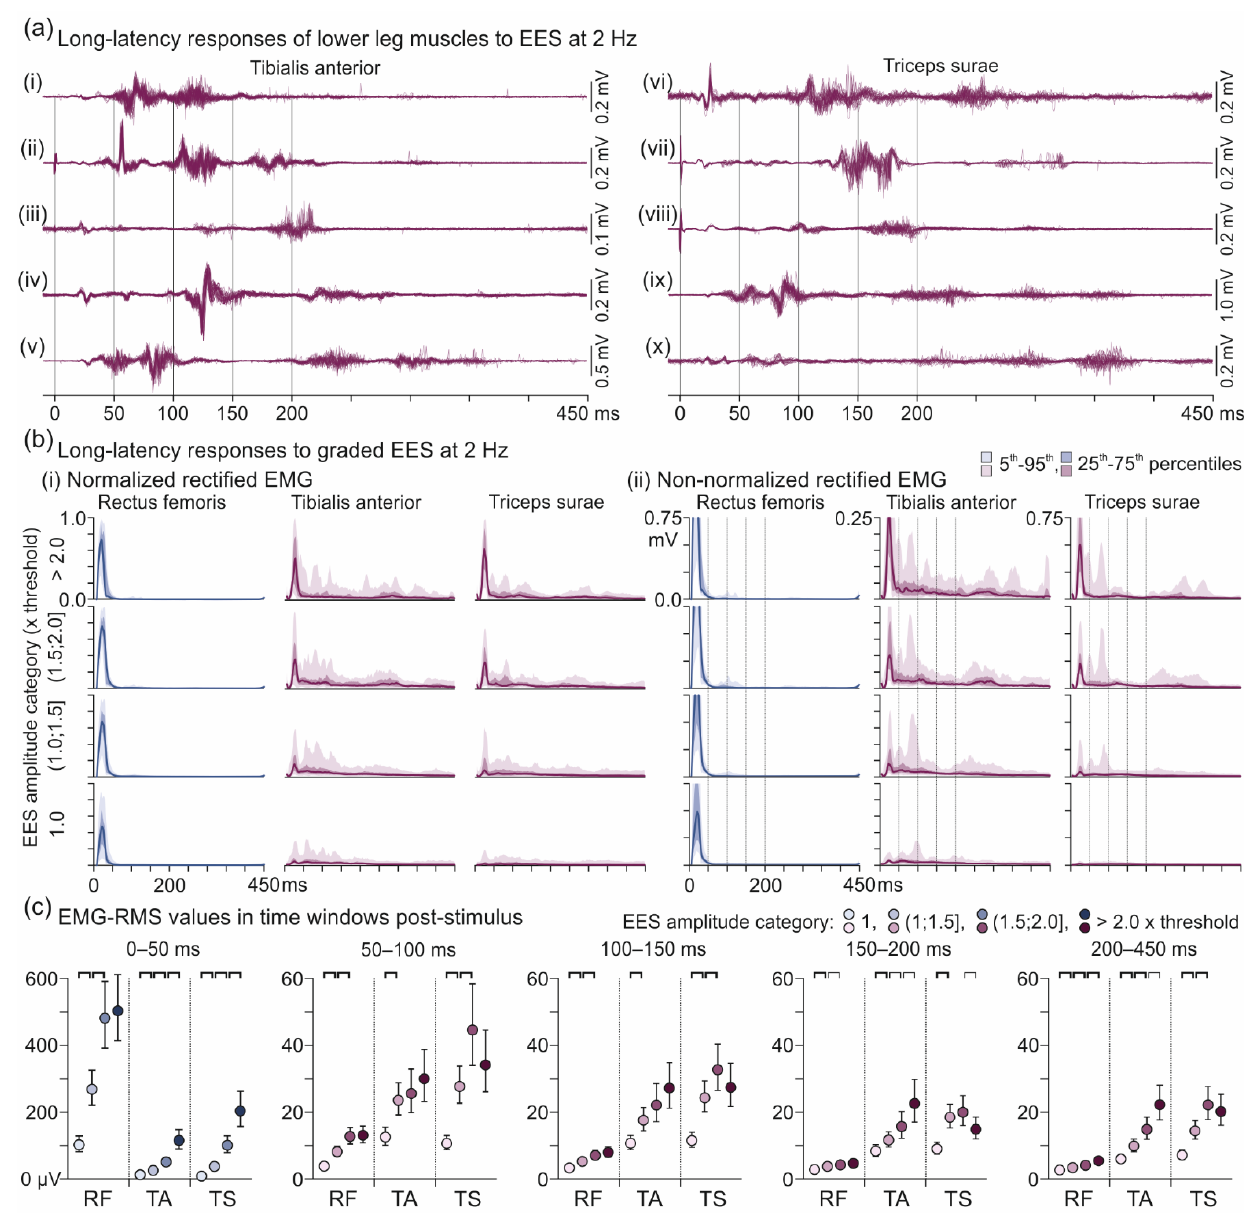
Figure 9. Long-latency responses in TA and TS to 2-Hz EES. ( a ) Various examples of complex, long-latency EMG activities in TA and TS evoked by EES over spinal cord segments rostral to those innervating the lower leg muscles. Shown are 19–36 stimulus-triggered traces superimposed for periods of 0–450 ms post-stimulus each. Four response time windows were defined from 0 to 200 ms and one from 200 to 450 ms. Peaks at time 0 are stimulus artifacts; evoked potentials within 0–50 ms are monosynaptic posterior root-muscle reflexes. ( i ) TA, subject 1, recording 1, 0 − 2+, 9 V; ( ii ) TA, subject 1, recording 3, 0 − c+, 7 V; ( iii ) TA, subject 6, recording 2, 0 − c+, 7 V; ( iv ) TA, subject 8, recording 2, 1+2 − , 9 V; ( v ) TA, subject 8, recording 4, 0 − 3+ 8 V; ( vi ) TS, subject 8, recording 2, 1+2 − , 9 V; ( vii ) TS, subject 3, recording 3, 0 − c+, 8 V; ( viii ) TS, subject 1, recording 2, 0+1 − , 8 V; ( ix ) TS, subject 8, recording 4, 0 − 3+, 7 V; ( x ) TS, subject 6, recording 3, 1+3 − , 8 V. ( b ) Group results of rectified EMG activities of RF, TA, and TS, ( i ) normalization to the respective maximum EMG response within the same muscle and recording and ( ii ), absolute EMG values. Solid lines are median values, shaded areas with increasing opacity cover the 25th–75th and 5th–95th percentiles, respectively. Data derived from six subjects, 13 recordings. In ( ii ), monosynaptic posterior root-muscle reflexes in RF are truncated. ( c ) EMG-RMS values calculated separately for EES amplitude categories and time windows as indicated. Data points are mean values, whiskers cover the 95% confidence interval. Brackets flag significant results of post-hoc contrasts (bold lines, p < 0.001; thin lines, p < 0.05). EES, epidural electrical stimulation; RF, rectus femoris; RMS, root mean square; TA, tibialis anterior; TS, triceps